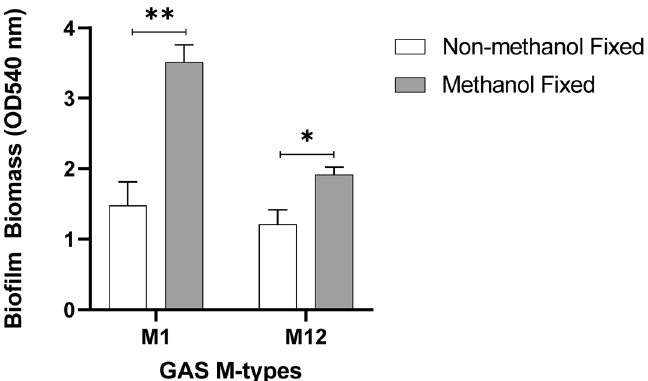
Figure 4. Methanol fixation improves M1 and M12 GAS biofilm biomass detection. 48 h GAS biofilms were formed from planktonic GAS that had initially adhered to the Detroit 562 pharyngeal cell monolayer after 2 h incubation. Biofilm biomass was ascertained via crystal violet staining. Monolayers with THY (no GAS biofilm) served as media sterility controls and background staining controls, with absorbance values subtracted from those of biofilm samples. Data represents mean ± SEM, * (P ≤ 0.05) and ** (P ≤ 0.01); n = 3 biological replicates, with 3 technical replicates